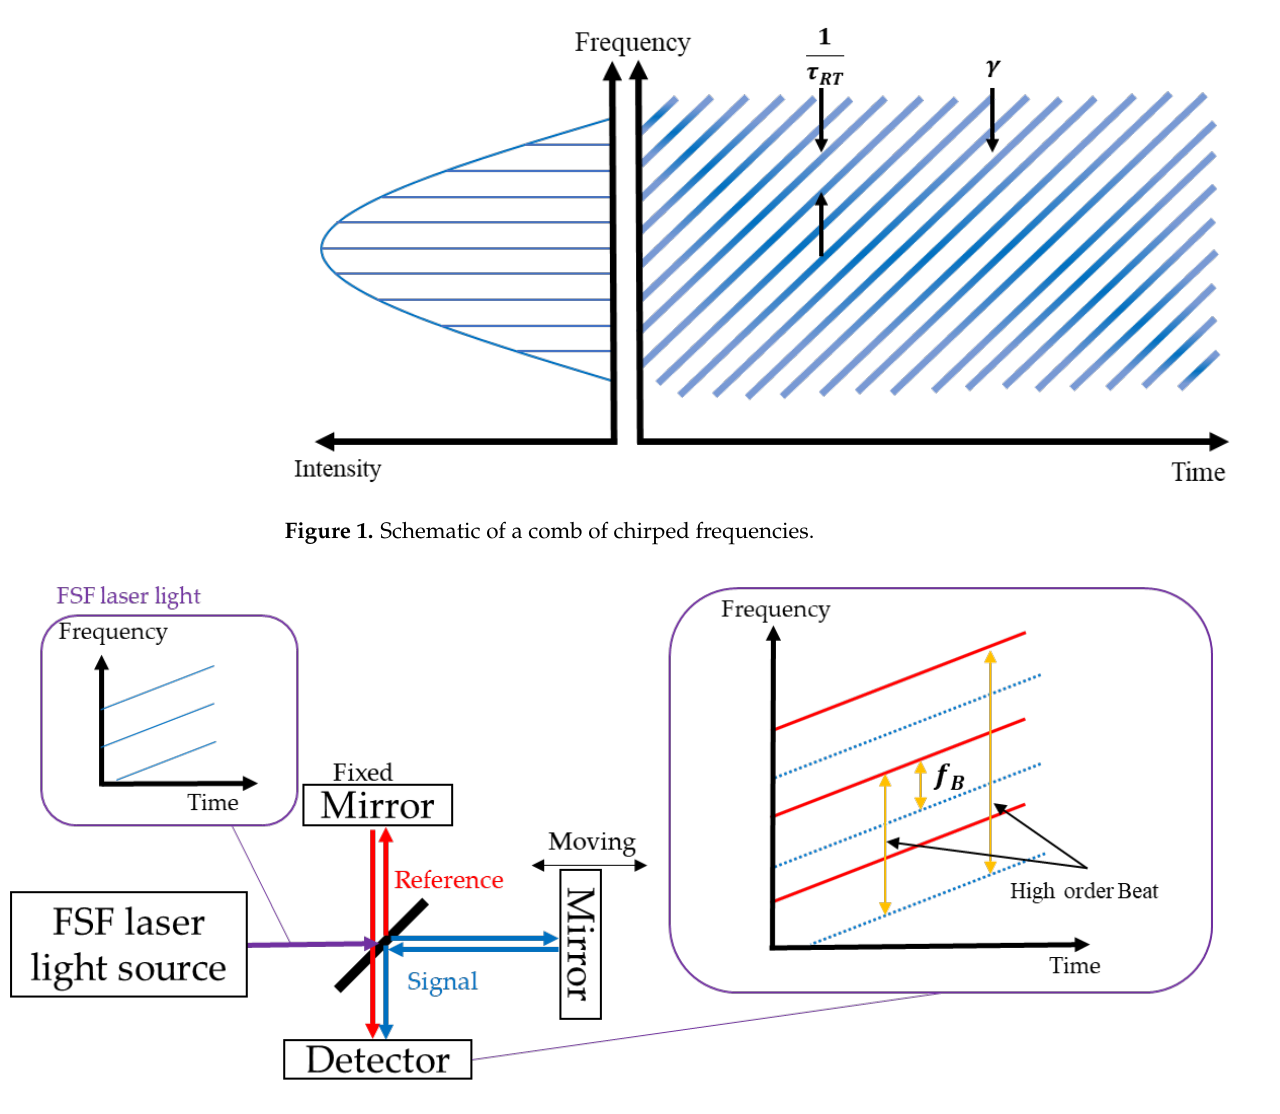
Figure 2. Optical frequency-domain reflectometry (OFDR) setup with a Michelson interferometer.